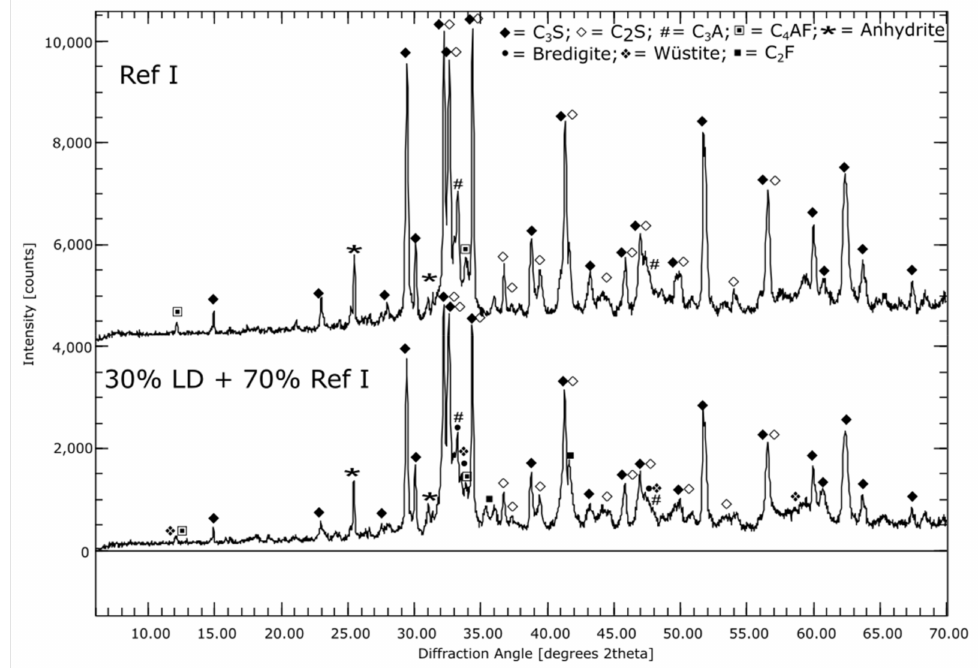
Figure A1. Graphical representation of XRD measurements: Ref I and LD.